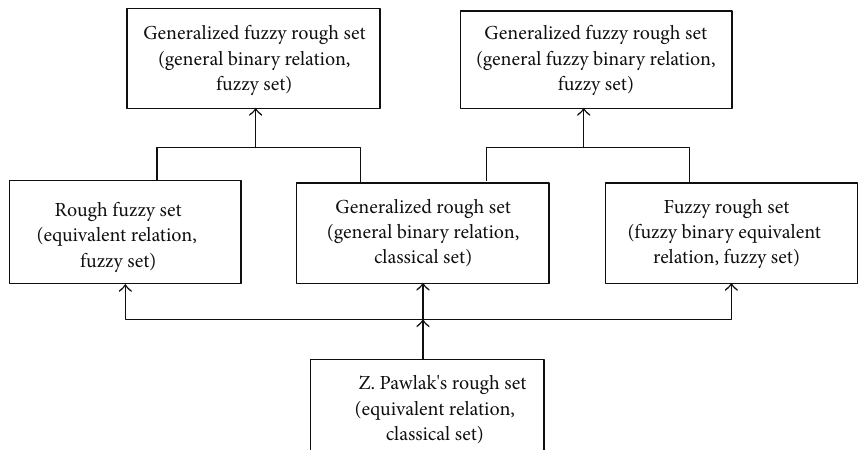
Figure 1: Select dependencies in rough set